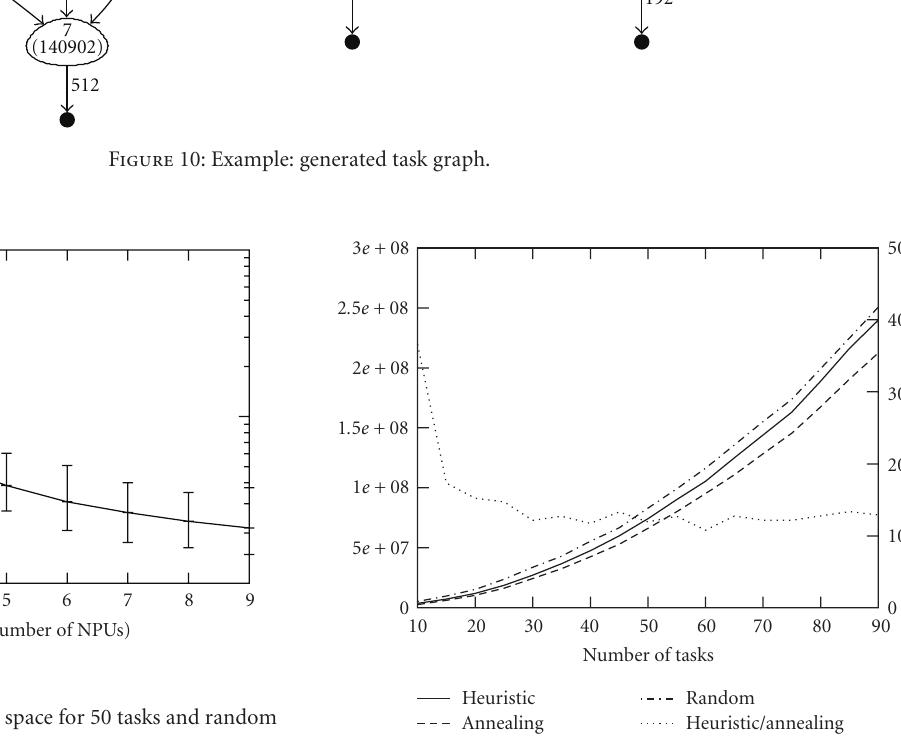
Figure 12: Objective function values (left y -axis) on a 3 × 3 NPU array and ratio in percent (right y